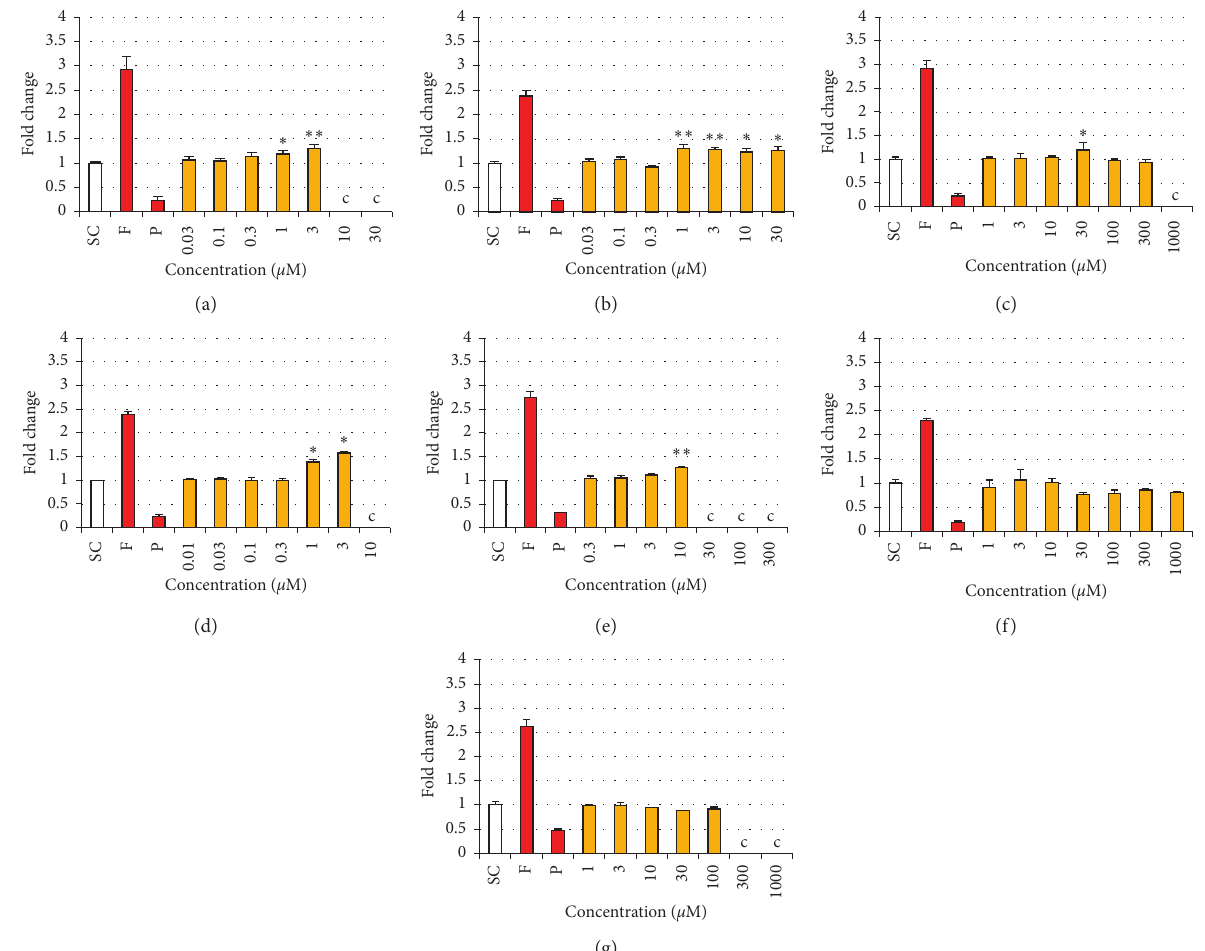
Figure 9: Testosterone production in H295R cells exposed to phthalates and substitutes. H295R cells were exposed for 48h to different concentrations of each phthalate and substitute, solvent control (SC), and forskolin 10 μ M (F) and prochloraz 1 μ M (P) as reference inducer and inhibitor of steroidogenesis. Results represent the mean fold change in hormone concentration compared to SC ( � 1) ± SD of 3 replicates from one representative assay out of at least 2 assays. c: cytotoxic concentration (viability < 80%) not analyzed. ∗ p < 0 . 05, ∗ ∗ p < 0 . 01. (a) DEHP. (b) DINP. (c) DEHT. (d) DINCH. (e) TOTM. (f) POLYSORB ® isosorbide. (g) POLYSORB ® ID